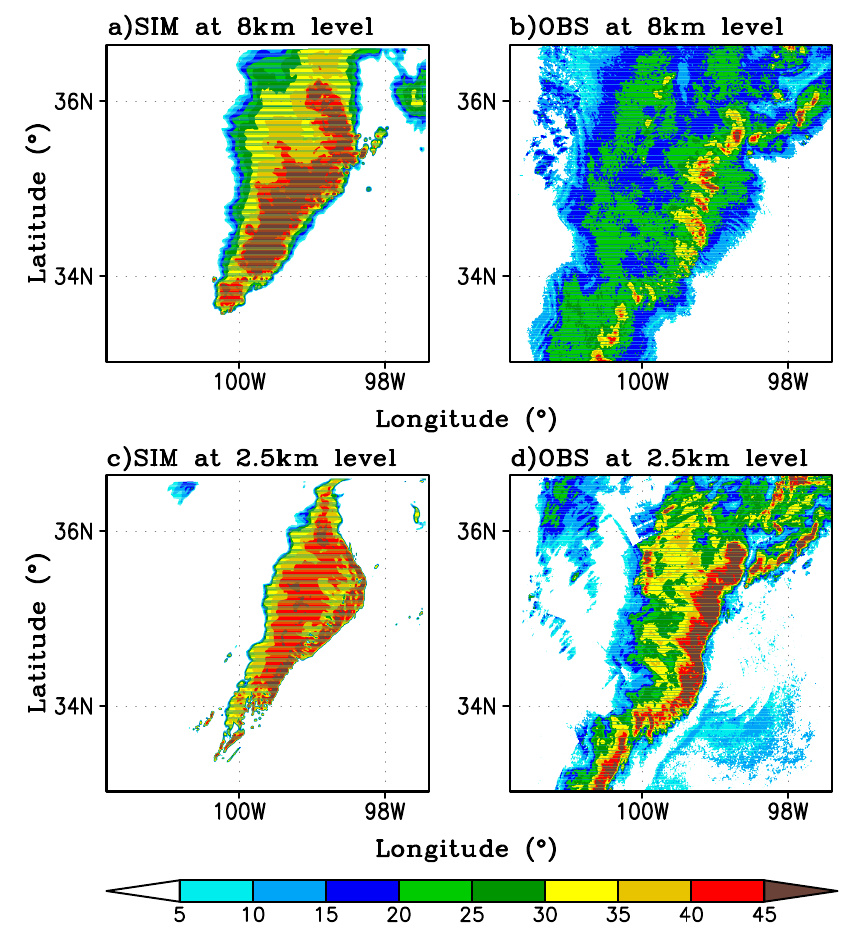
Figure 3. Comparison between the cloud-resolving model (CRM) simulation and observations of radar reflectivity (in dBZ). ( a ) simulation and ( b ) observation at 8 km height, and ( c ) simulation and ( d ) observation at 2.5 km height at 08 UTC on 20 May 2011.